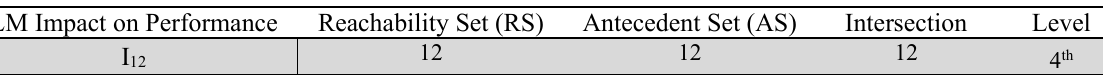
Fifth Level Partition LM Impact on Performance